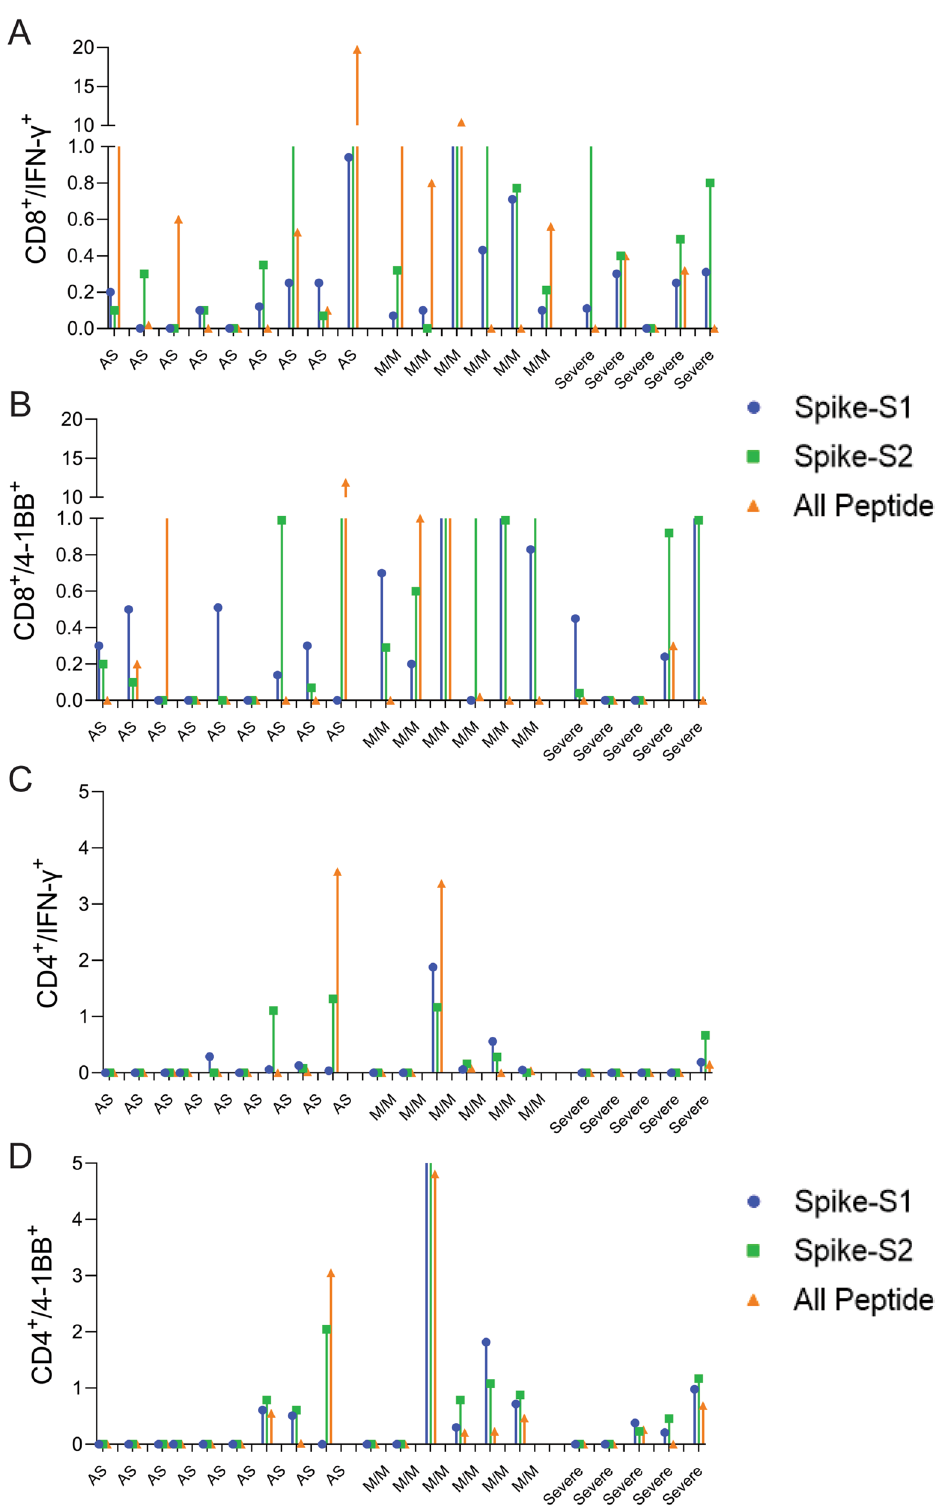
Figure 5. T-cell reactivity to Spike-S1, S2 pools, and 11-peptide-mix in asymptomatic, mild-moderate, and severe disease patients after in vitro stimulation for 48 h. ( A ) Convalescent patient PBMC collected between 45–60 days after PCR confirmation of COVID-19 infection was incubated with spike-S1 or S2 peptide pools or the All-peptide mix. T-cell activation was quantitated by intracellular IFN-γ and 4-1BB expression by FACS. T-cell activation for individual donors is plotted. ( A , B ) IFN-γ and 4-1BB expression in activated CD8 T-cells in asymptomatic (AS, 9 patients), mild/moderate (M/M, 6 patients) and severe (5 patients). ( C , D ) IFN-γ and 4-1BB expression in activated CD4 T-cells in the three patient groups. Differences in T-cell activation between groups were not statistically significant by Students T-test. Group-wise aggregated data is shown in Figure